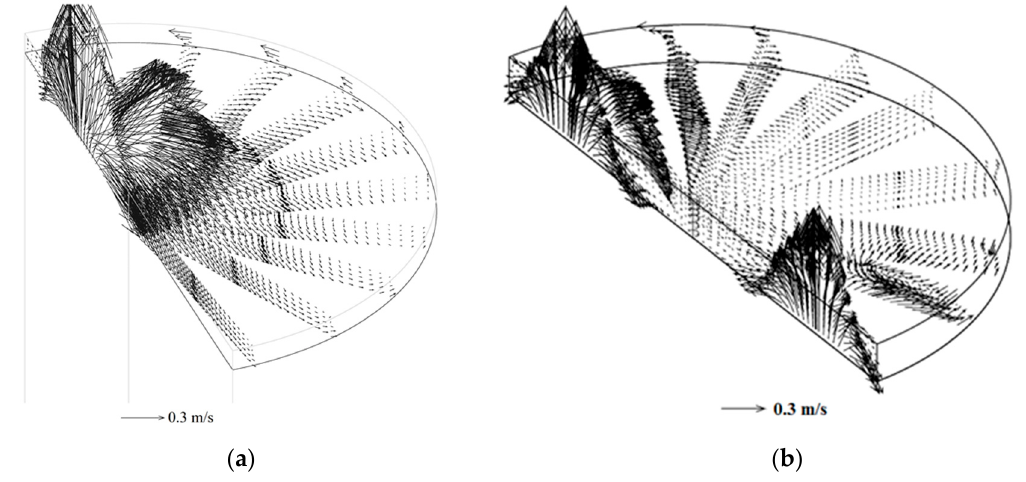
Figure 6. Details of 3D velocity patterns on the top slag layer ( a ) Single plug gas injection (i.e., one nozzle) located at 1/2 R; ( b ) dual plug as injection (two nozzles) located at 2/3 R. In both the cases, a complex slag flow pattern is observed.